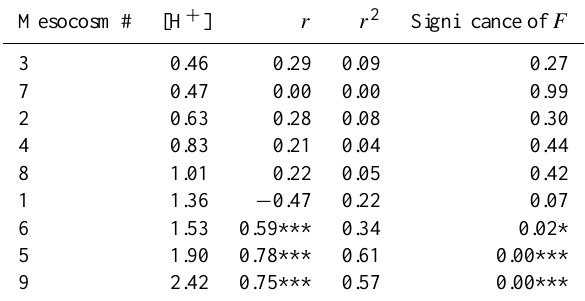
Table 2. Significance of the relationship between bacterial produc- tion and the DMS:DMSPt ratio during the experiment for each mesocosm and corresponding [H + ] ( × 10 − 8 EqL − 1 ) . Values are the Pearson correlation coefficient ( r ), the coefficient of determi- nation ( r 2 ) and the significance of the linear relationship: F-ratio of the ANOVA of the linear regression (Significance: * P < 0 . 05, *** P < 0 . 001) ( n = 16). The Durbin–Watson statistic computed for mesocosms 6, 5 and 9 was higher than the critical value (up- per limit 1.371, n = 16) confirming limited autocorrelation in the data and the validity of the significance values of F .